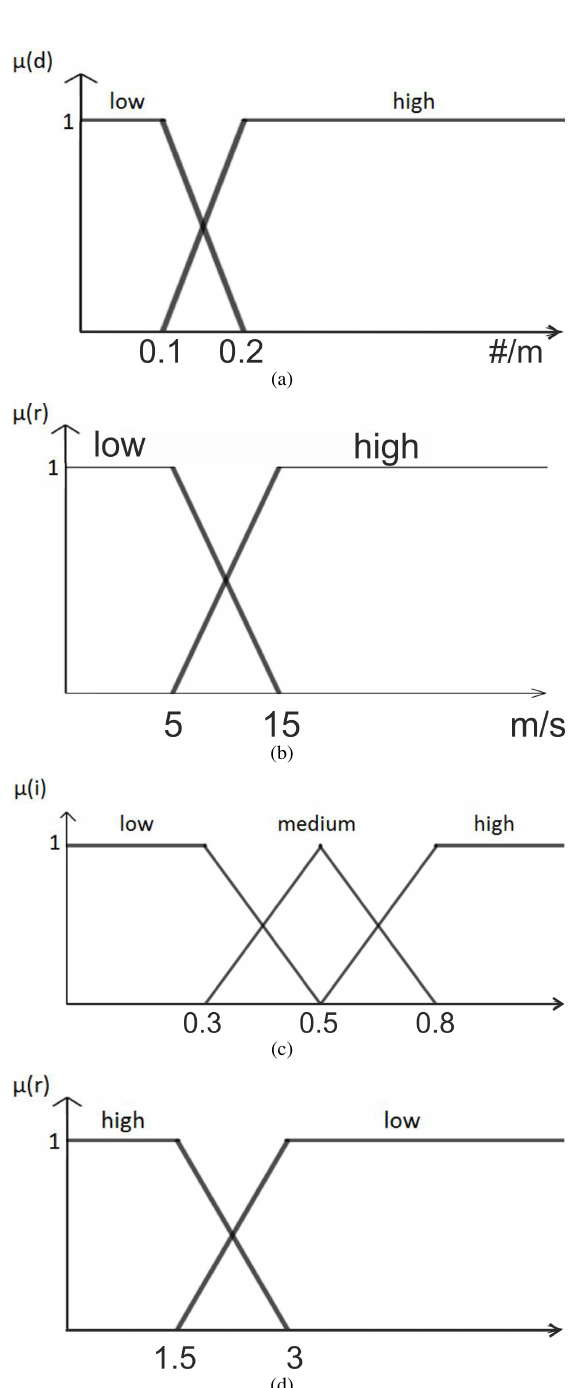
Figure 9. Trapezoidal membership functions of the linguistic variables vehicle density (a), vehicle speed (b), weight parameter of traffic lights or intersections (c) and road category